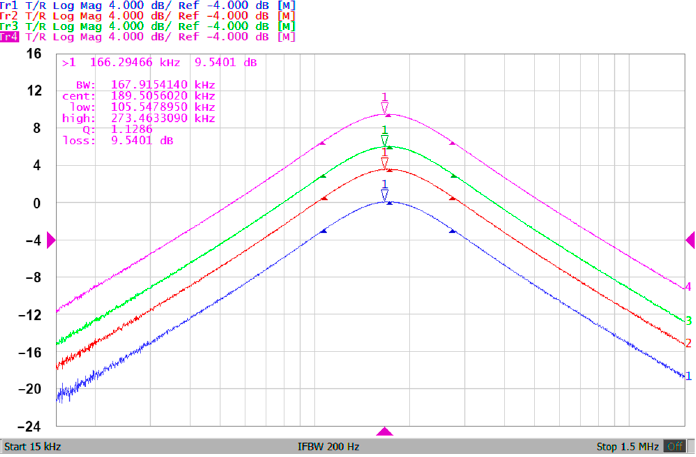
Figure 29. The measured magnitude responses of the V BP5 when g m2 was varied.